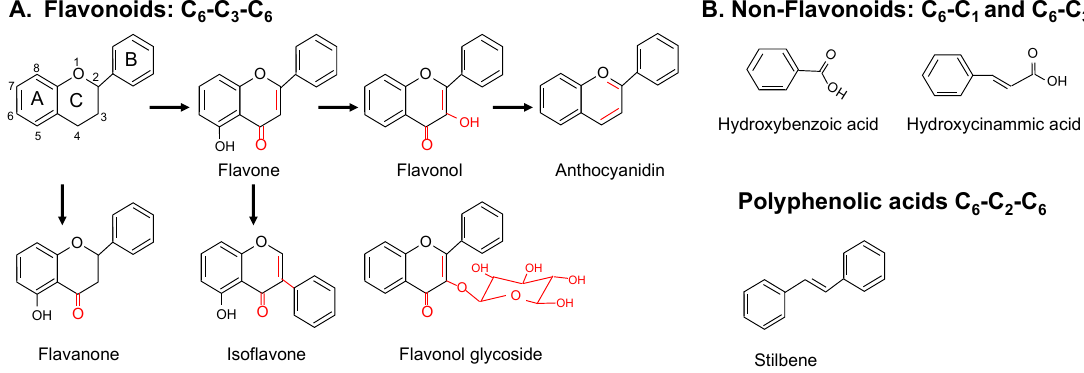
Figure 1. Structure of polyphenols. Polyphenols are divided into flavonoids ( A ) and non- flavonoids ( B ). Modifications to ring C and the addition of sugars to ring C (in red) allows for further sub-classifications. An example of flavanols are catechins, which are found in berries, apples, tea, and cocoa